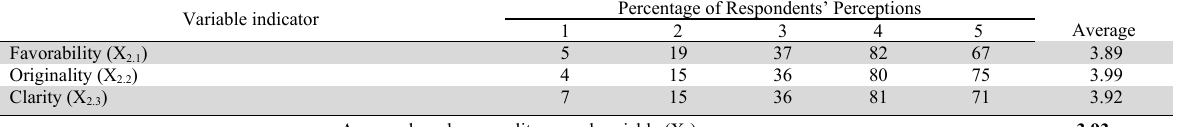
Description of Respondents' Perceptions of Brand Personality Appeal Indicators (X 2 ) Variable